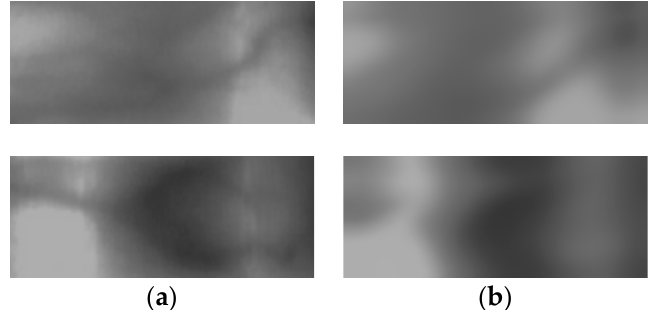
Figure 8. Examples of original and blurred images of SDU-DB. ( a ) Original images, ( b ) motion and optical blurred images.